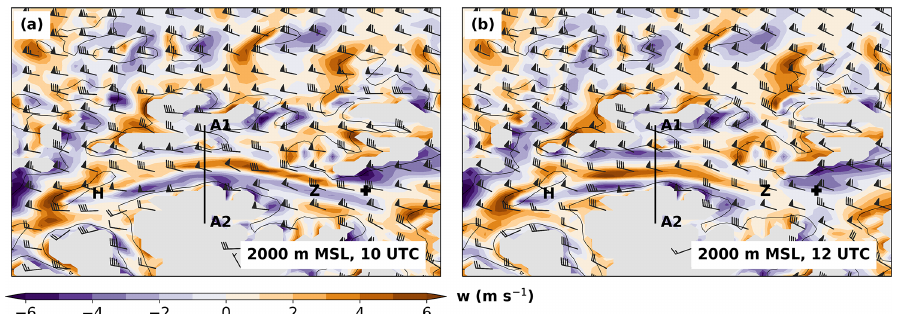
Figure 3. Simulated horizontal wind and vertical velocity at 2000ma.m.s.l. at (a) 10:00UTC and (b) 12:00UTC on 29 October 2017 in subdomain SD3. Horizontal wind is depicted by wind barbs as in Fig. 2b, vertical velocities are illustrated by color contours. Model topog- raphy is indicated by black contour lines for the elevation of 1500ma.m.s.l., and areas with model topography higher than 2000ma.m.s.l. are shaded in grey. Locations of Haiming (H) and Zirl (Z) are indicated by letters, the location of Innsbruck is indicated by a black cross. The orientation of the vertical cross section CS_CRINN is depicted by a thick black line with A1 and A2 being the start and end points of the cross section as in Fig.